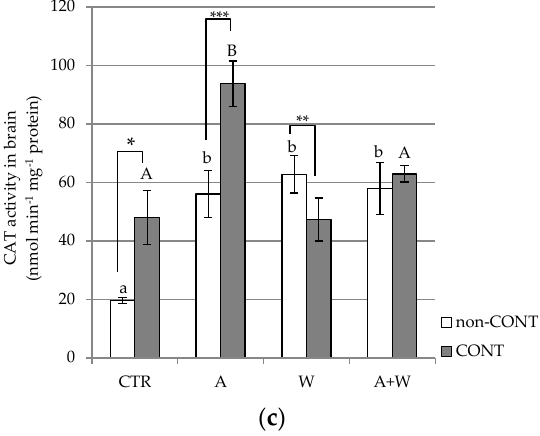
Figure 2. Catalase (CAT) activity (nmol ∙ min − 1 ∙ mg − 1 protein, mean ± SD) in S. senegalensis muscle ( a ), liver ( b ), and brain ( c ) after 28 days of Hg exposure. White bars represent non-contaminated treatments (non-CONT) and gray bars represent Hg-contaminated treatments (CONT). Control (CTR)—seawater temperature set at 19 °C and pH set at 8.0 units; A—seawater temperature set at 19 °C and pH set at 7.6 units; W—seawater temperature set at 23 °C and pH set at 8.0 units; A + W— seawater temperature set at 23 °C and pH set at 7.6 units. Different small letters denote significant differences between non-CONT treatments (ANOVA, p < 0.05). Different capital letters denote significant differences between CONT treatments (ANOVA, p < 0.05). Asterisks (*) represent differences between non-CONT and CONT for the same conditions (Student’s t -test: * p < 0.05; ** p < 0.005; *** p < 0.0005).